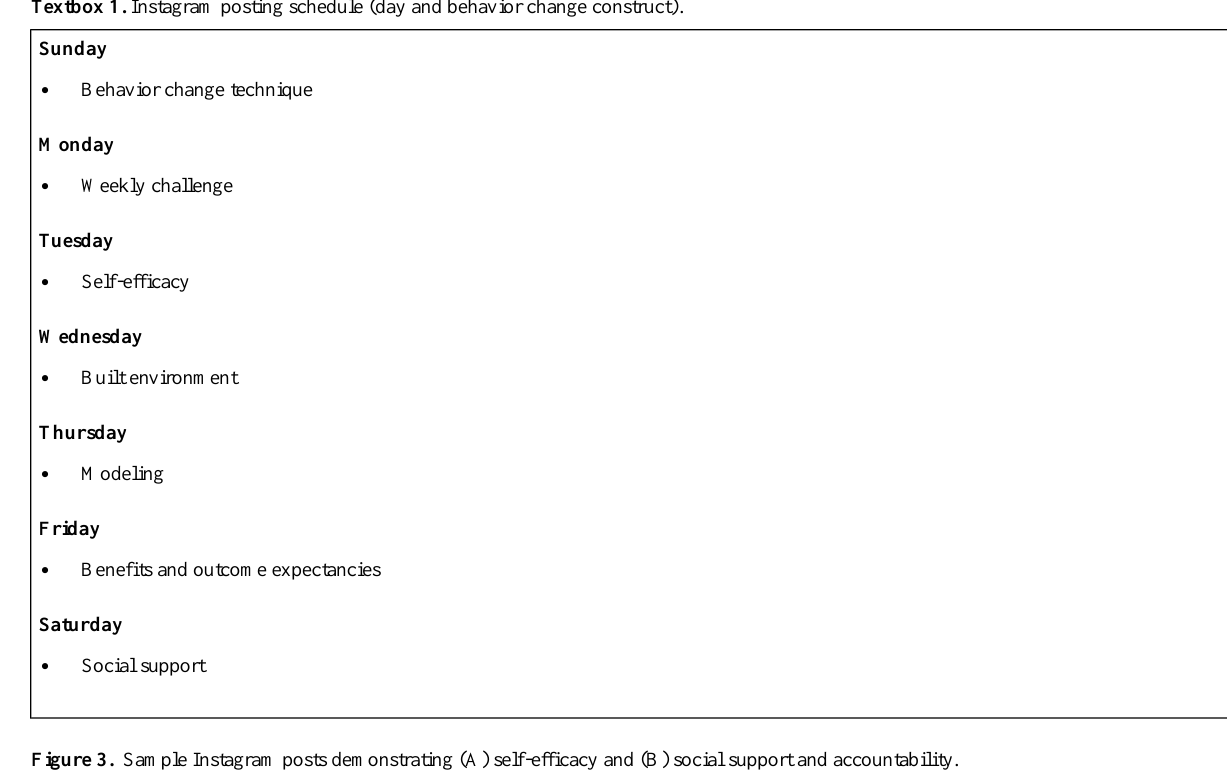
Figure 3. Sample Instagram posts demonstrating (A) self-efficacy and (B) social support and